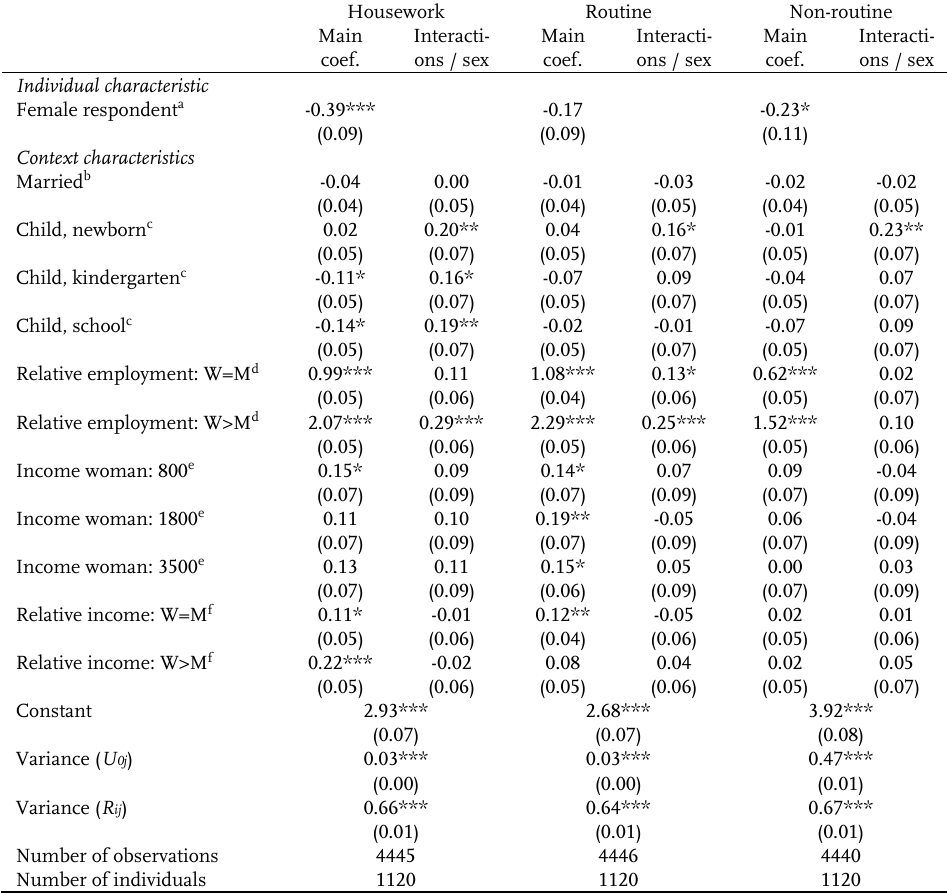
Housework Routine Non-routine Main Interacti- Main Interacti- Main Interacti- coef. ons / sex coef. ons / sex coef. ons / sex